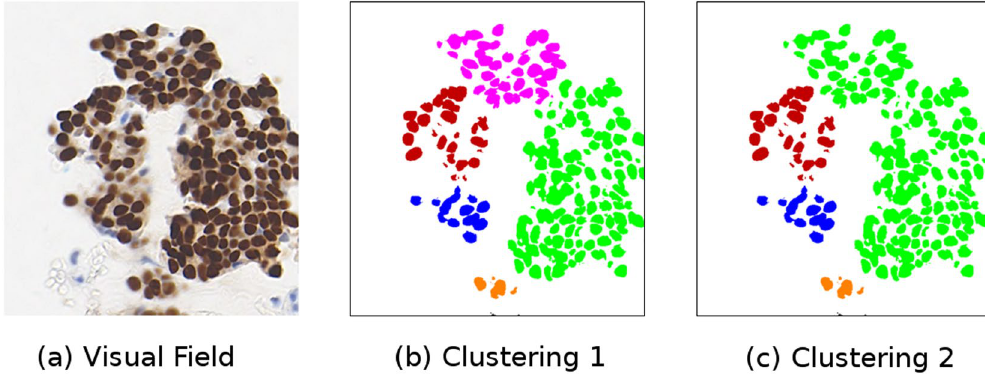
Figure 7. An example of two potential nuclei clusterings. Figure 7a shows the original image, Fig. 7b shows one potential clustering of the detected nuclei, Fig. 7c shows a different potential clustering of the detected